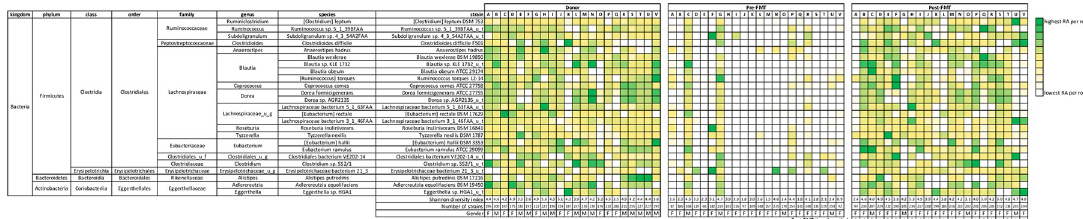
Fig 4. Heat map depicting the top 25 bacterial strains according to relative abundance in the healthy donor group. Shannon diversity index and number of bacterial strains (BSI) in each fecal sample are depicted at the bottom of the heat